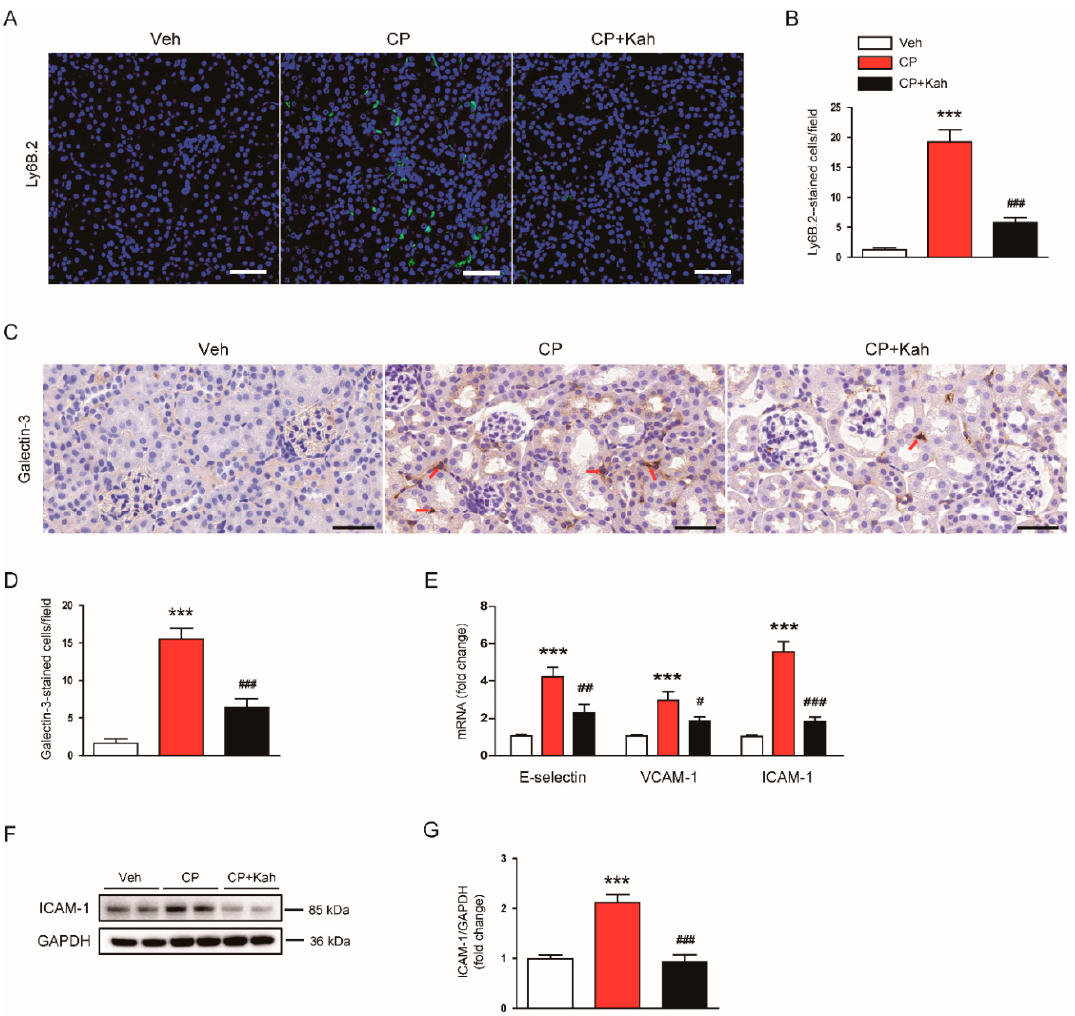
Figure 10. E ff ect of kahweol on immune cell accumulation in cisplatin-injected mice. ( A ) Immunofluorescent staining of kidney tissues for Ly6B.2. Scale bar = 50 µ m. ( B ) Number of Ly6B.2-stained cells. ( C ) Immunohistochemical staining of kidney tissues for galectin-3. Red arrows indicate positively stained cells. Scale bar = 100 µ m. ( D ) Number of galectin-3-stained cells. ( E ) The mRNA levels of E-selectin, vascular cell adhesion molecule-1 (VCAM-1), and intercellular adhesion molecule-1 (ICAM-1). ( F ) Western blotting of ICAM-1. ( G ) Quantification of Western blot for ICAM-1. GAPDH was used as an internal control. n = 8 per group. *** p < 0.001 compared with Veh. # p < 0.05, ## p < 0.01 and ### p < 0.001 compared with